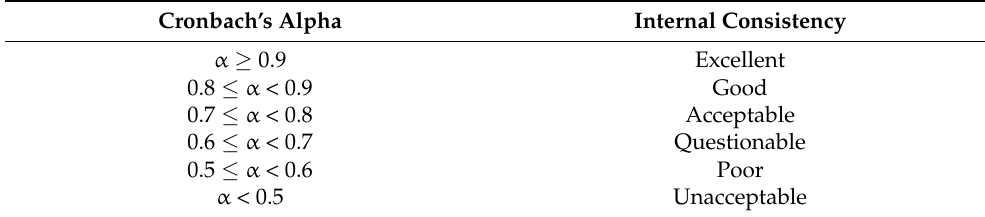
Table 1. Interpreting Cronbach’s alpha for Likert-scale